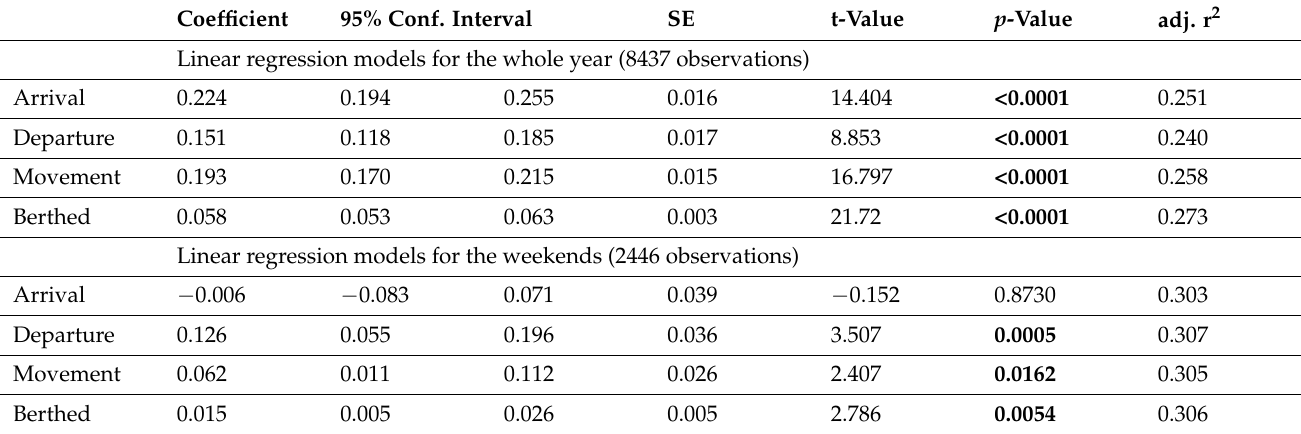
Table 4. Multivariable linear regression analysis results for vessel arrivals, departures, movement and laying alongside to the logarithm of NO 2 hourly mean concentrations controlled for wind direction, wind speed, relative humidity, air temperature and time of day at Vuosaari 2016. Coefficients calculated for observations for the whole year and for weekends only. p -values less than 0.05 are in bold.